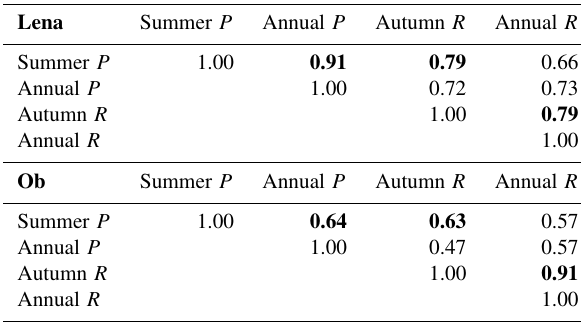
Table 1. Correlation coefficients among the summer P , annual P , autumn R , and annual R for the Lena and Ob rivers during 1936–2009. The summer (autumn) averaging period is from June to September (from August to October). The P and R are based on Arctic-RIMS and GPCC. All values are above the 99% confidence level. Bold values are specifically described in the